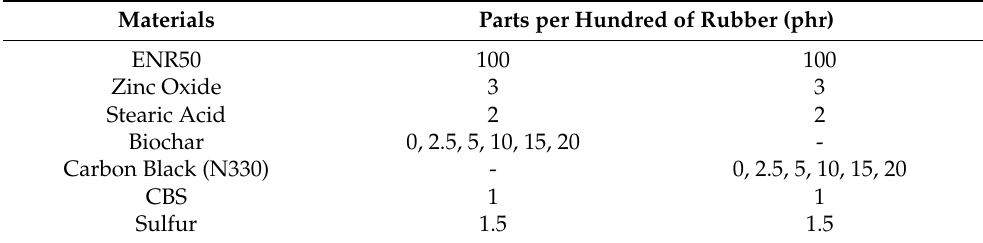
Table 1. Formulation of epoxidized natural rubber